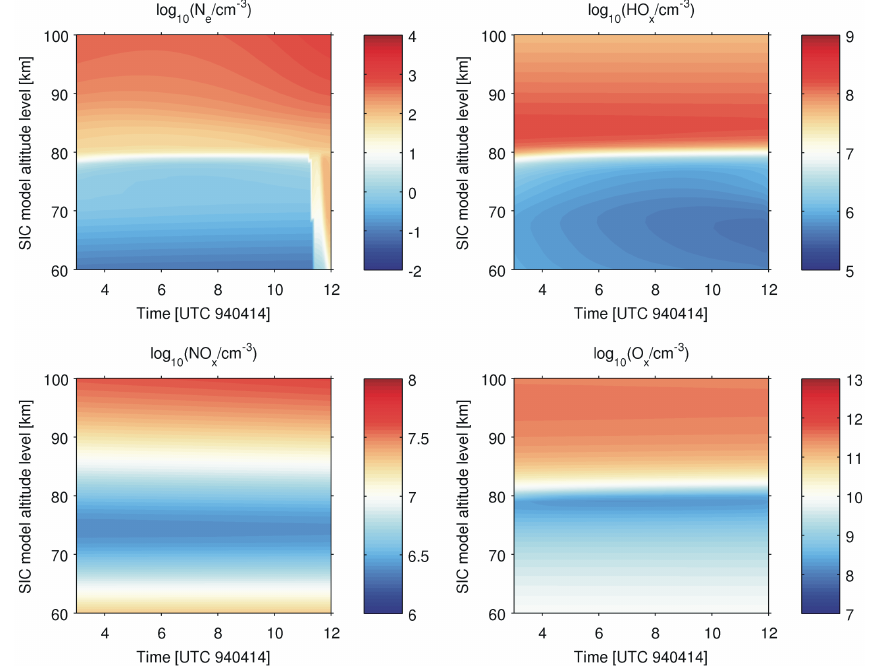
Fig. 6. The results of a SIC modelling run without any WEP-forcing (i.e. zero precipitating electron fluxes), showing the calculated “normal”